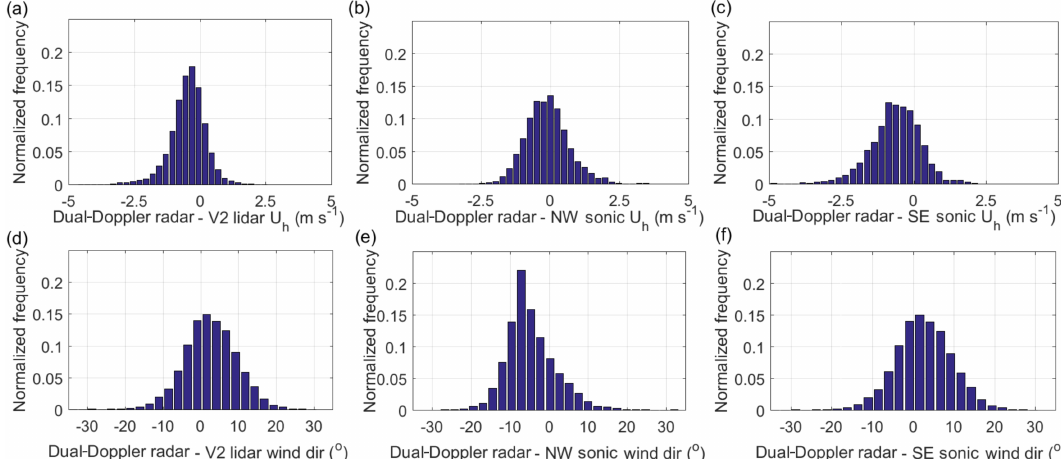
Figure 6. Difference of dual-Doppler radar retrieval with the reference instruments, i.e., sonic anemometers and V2 lidar, for all the tested